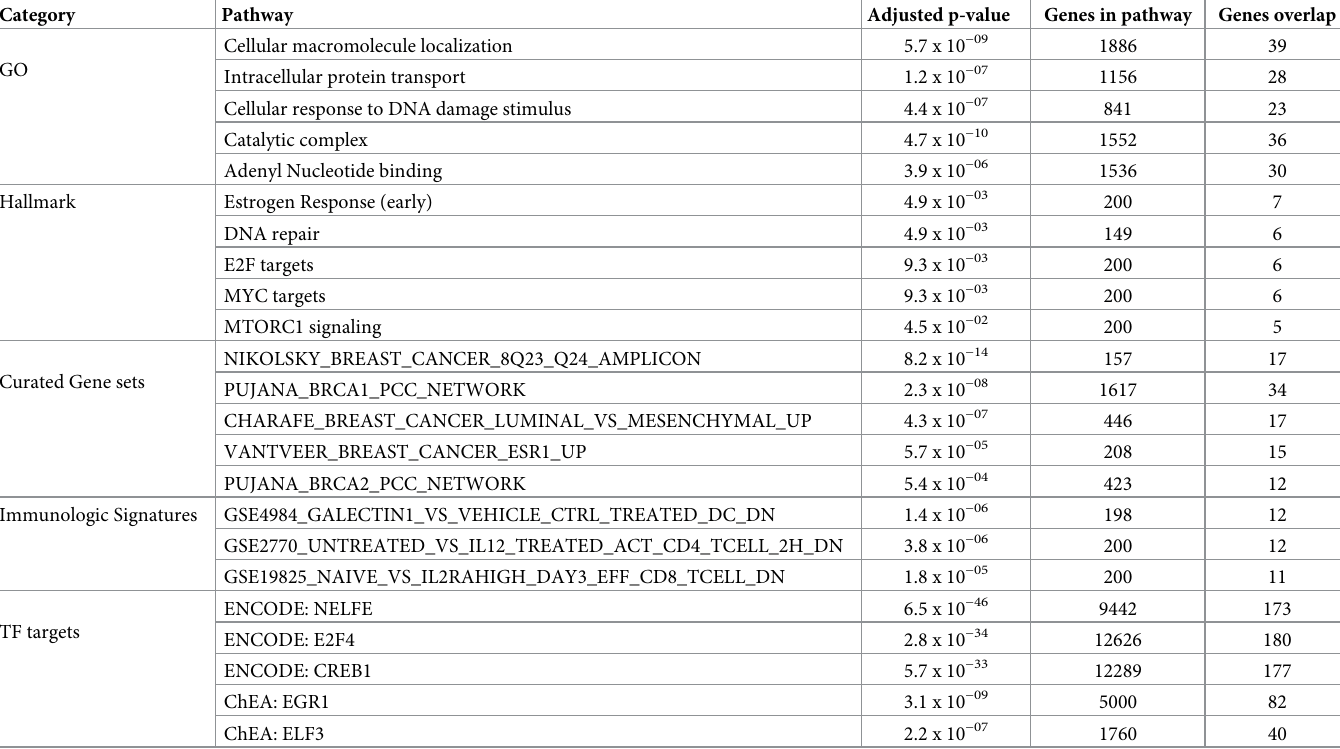
Table 3. Different categories of pathways enriched for the 210 genes associated (FDR < 0.05) with ER status.